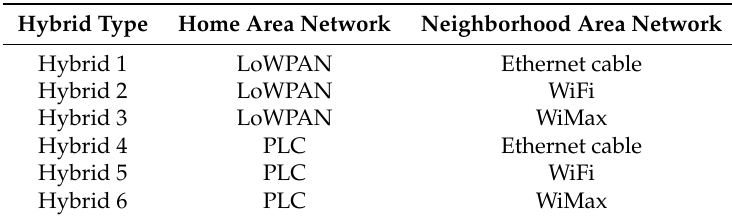
Table 1. Hybrid communication architectures.